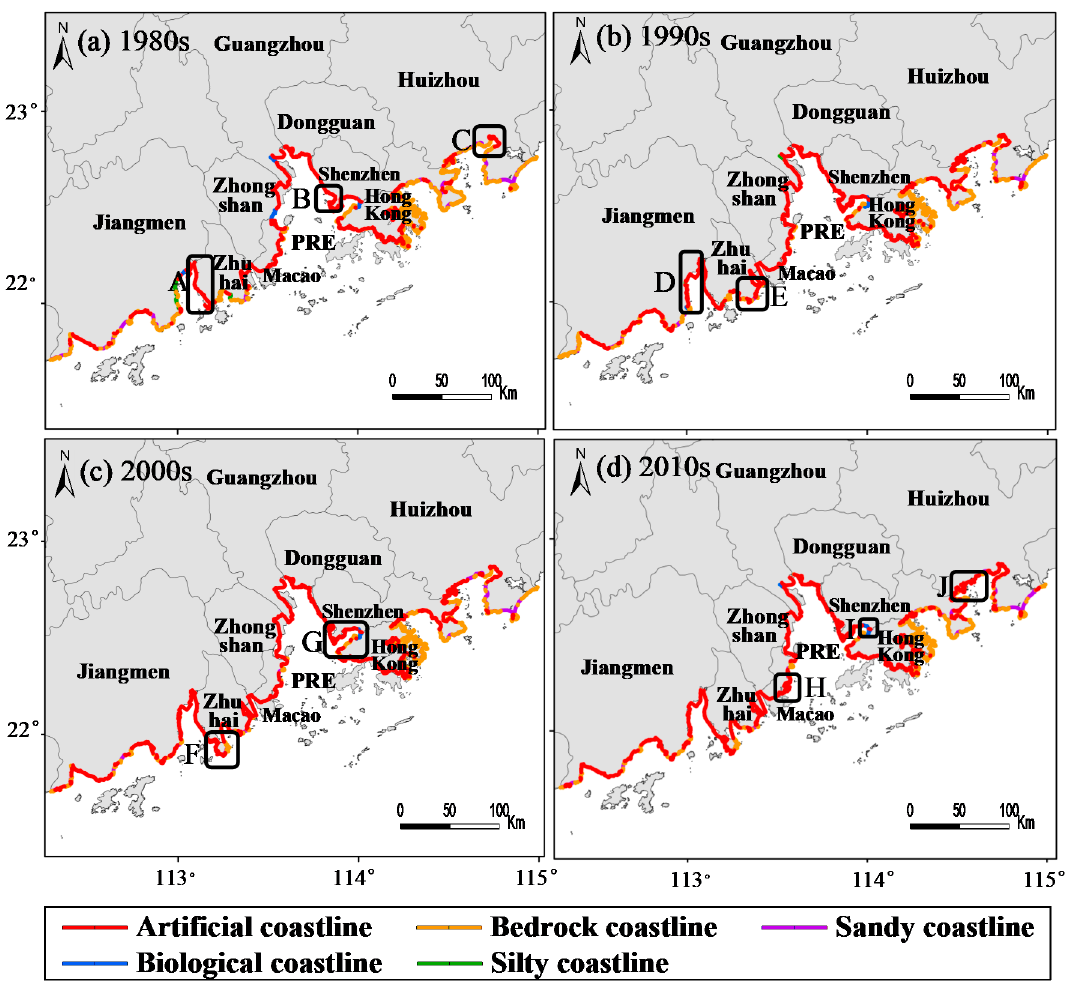
Figure 4. Distribution of different types of coastlines in the GHMGBA over four decades: ( a ) 1980s; ( b ) 1990s; ( c ) 2000s; and ( d ) 2010s. Box A: East coast of Huangmao Sea, Box B: Qianhai Bay, Box C: Fanhe Port in Huidong County, Box D: West coast of Huangmao Sea, Box E: Sanzao Island, Box F: Gaolan Island, Box G: Qianhai Bay, Houhai Bay and Shekou Peninsula, Box H: Jinwan District, Box I: Shenzhen Futian Mangrove Nature Reserve and Box J: Daya Bay Petrochemical Industrial Zone, located in Huiyang District.